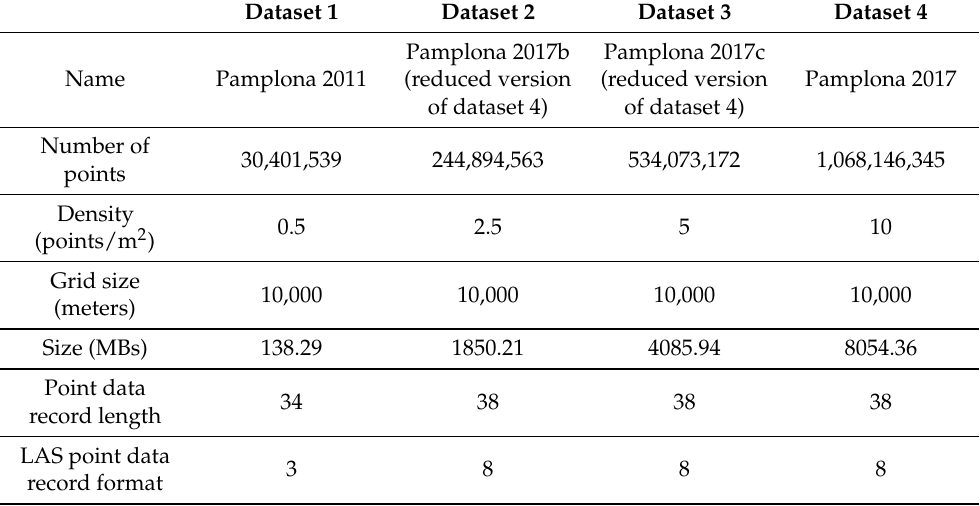
Table 1. Datasets